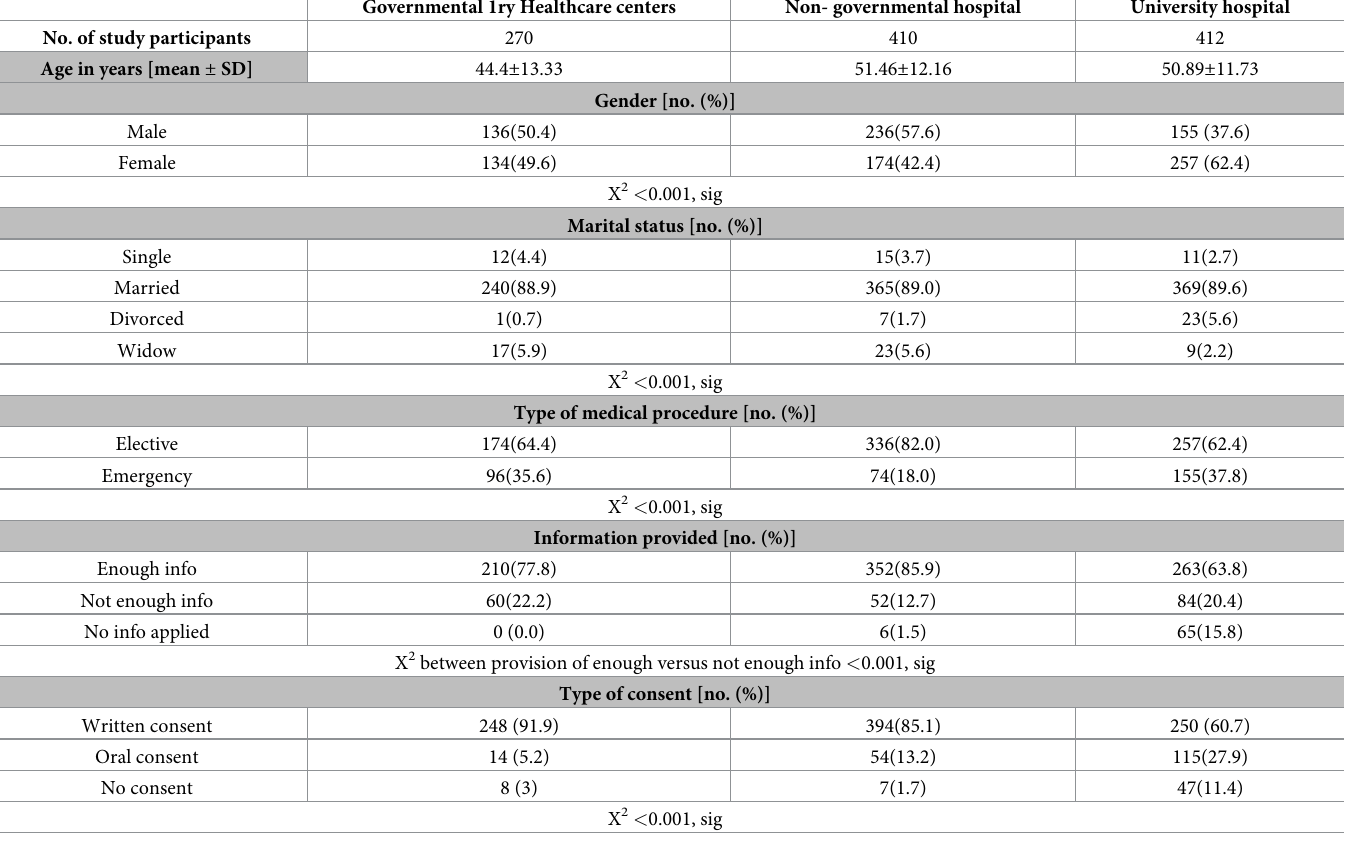
Table 1. Socio-demographic characteristics of the study participants according to the type of the healthcare